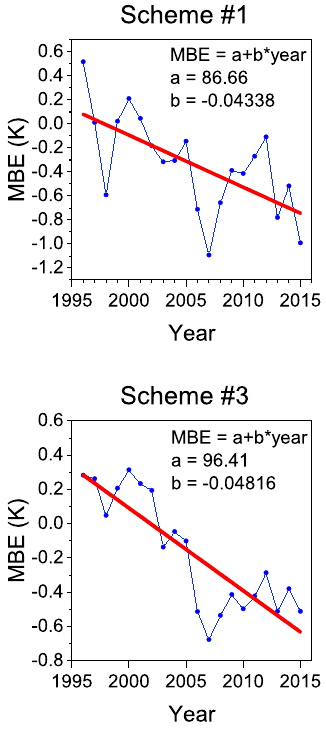
Figure 9. The yearly MBEs of different modeling schemes from 1996 to 2015. Blue dots are yearly biases of each modeling scheme and red lines are their linear fit ( N ens = 10; N hid =